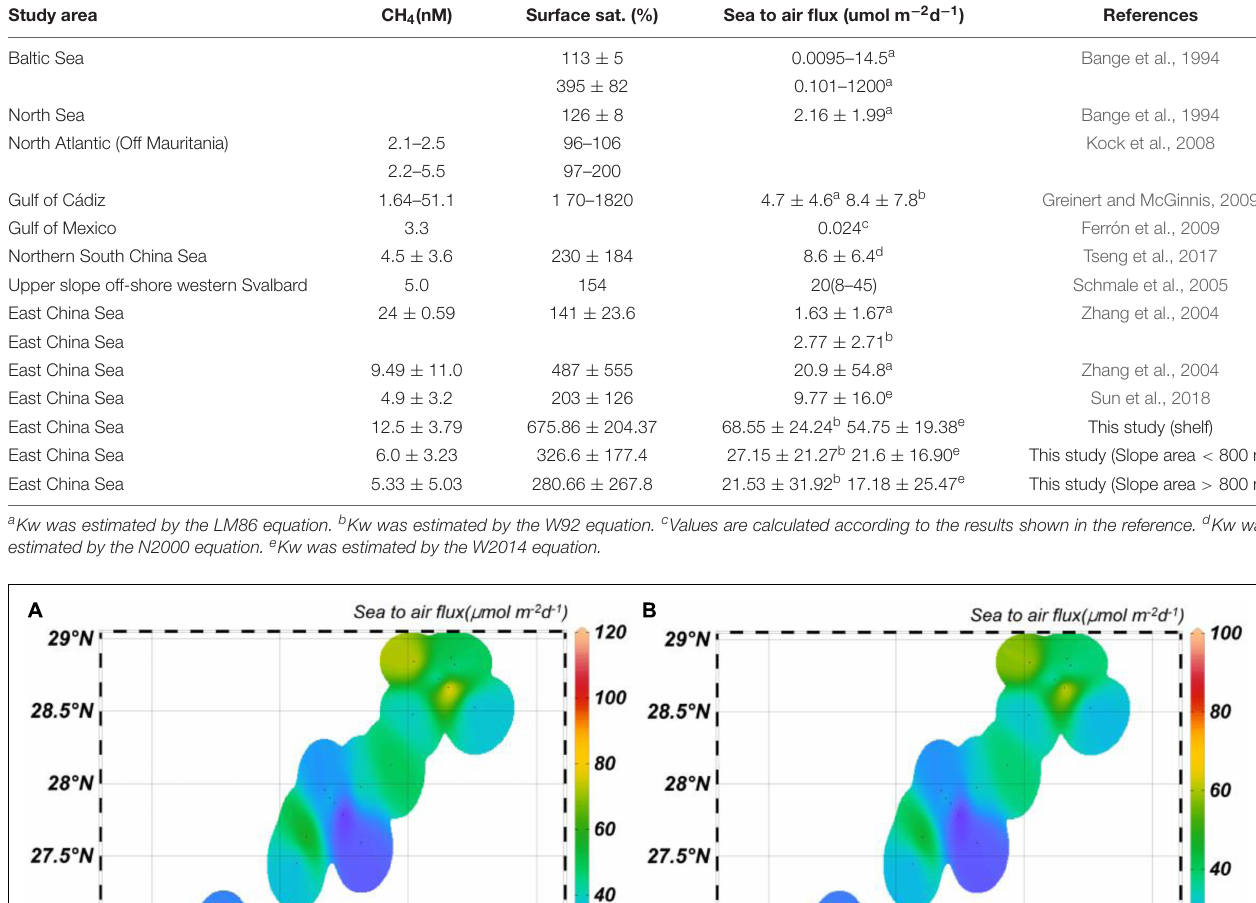
TABLE 1 | Surface concentrations, surface saturations, and sea-to-air fluxes of CH 4 reported in different oceanic areas. Study area CH 4 (nM) Surface sat.